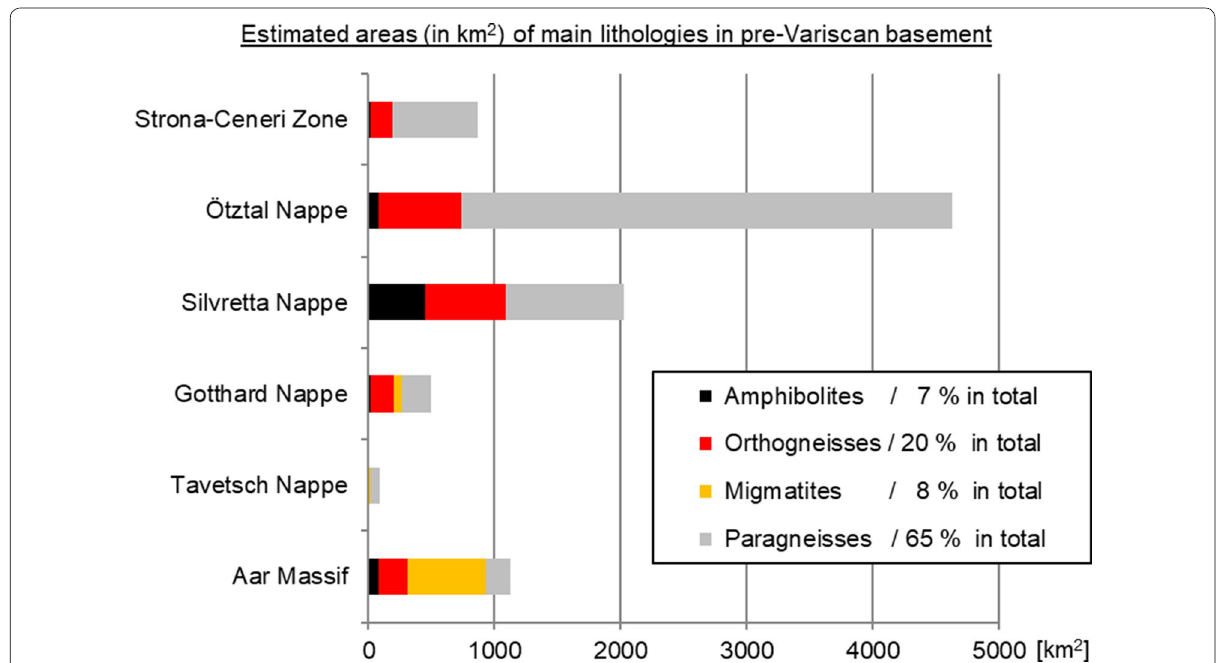
Fig. 6 Map area percentages (data of Table 2) of the amphibolites, orthogneisses, migmatites and paragneisses in the pre-Variscan basement units of the